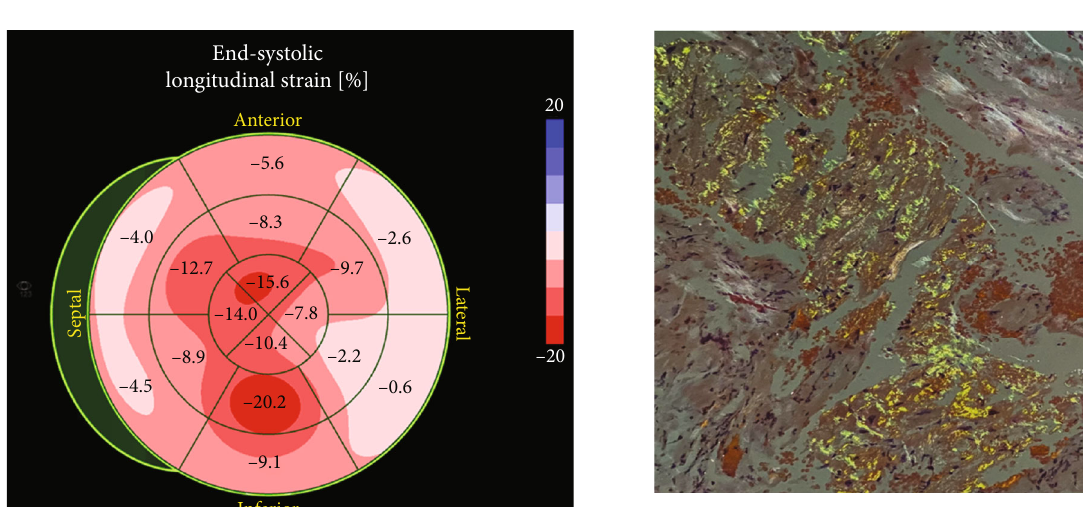
Figure 5: Cardiac biopsy with Congo red stain, demonstrating apple green birefringence in polarized light, consistent with amyloidosis.